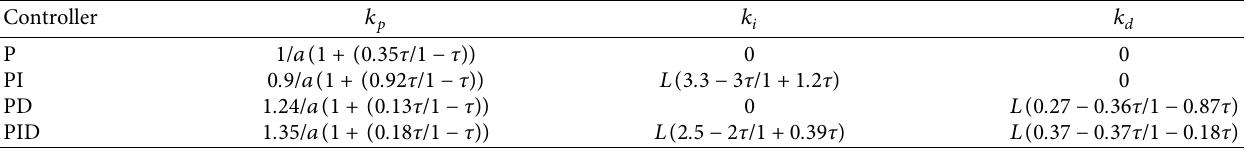
Table 4: The Cohen-Coon tuning rules (0% overshoot). Note that these rules produce a quarter-amplitude damping response [52].